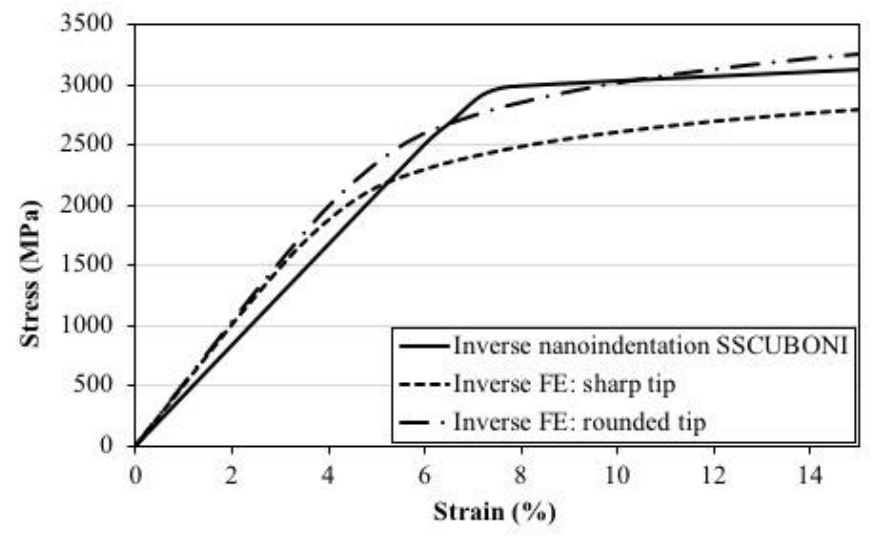
Figure 14. Comparison of the S-S curves of the experimental compression test with the corresponding inverse numerical nanoindentation results and the inverse SSCUBONI-based experimental test for the W-Cu specimens.